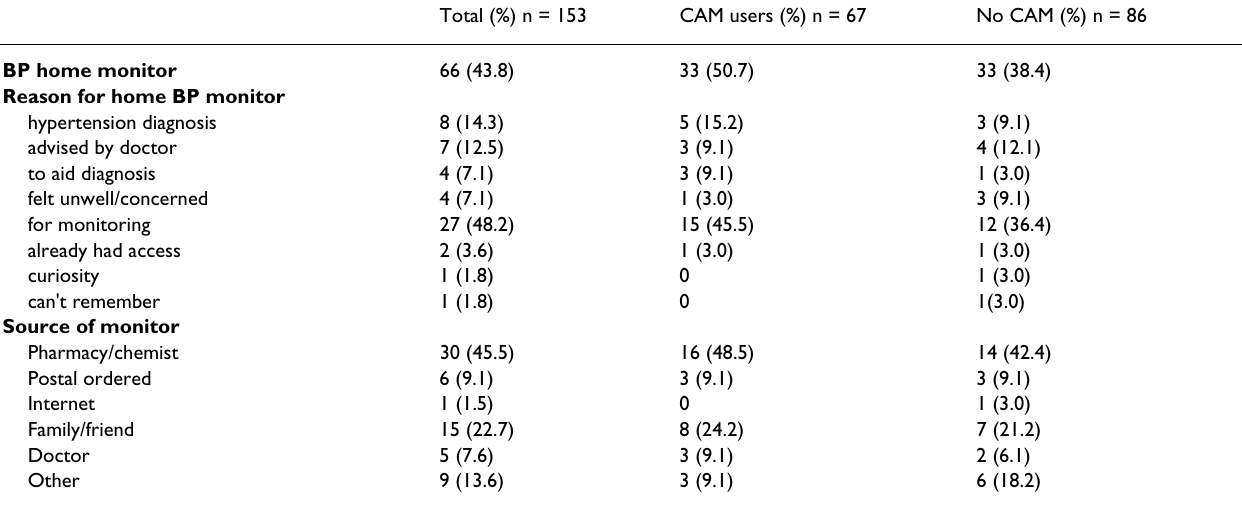
Table 4: Use of home monitoring tests for all respondents, and by CAM use and gender Total (%) n =